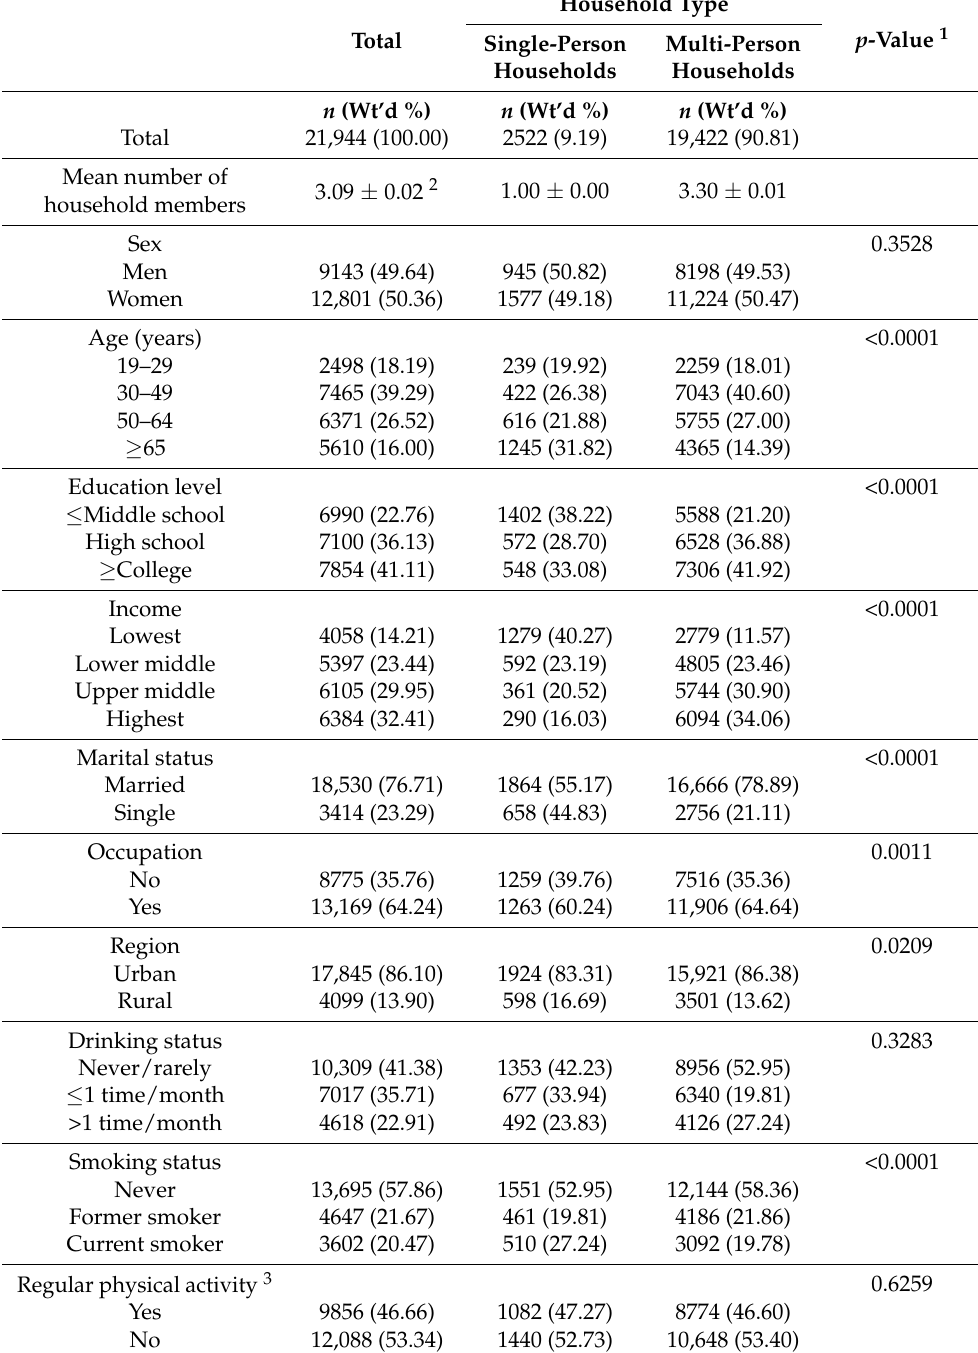
Table 1. General characteristics of study participants according to household types in Korean adults, KNHANES 2014–2018.